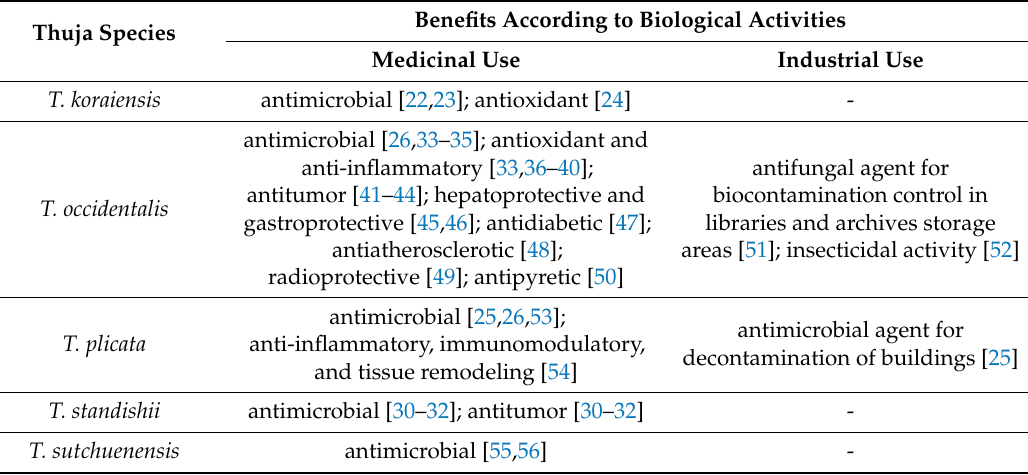
Table 1. Comparison of the bioactive potential of T. occidentalis with other Thuja genus species. Thuja Species